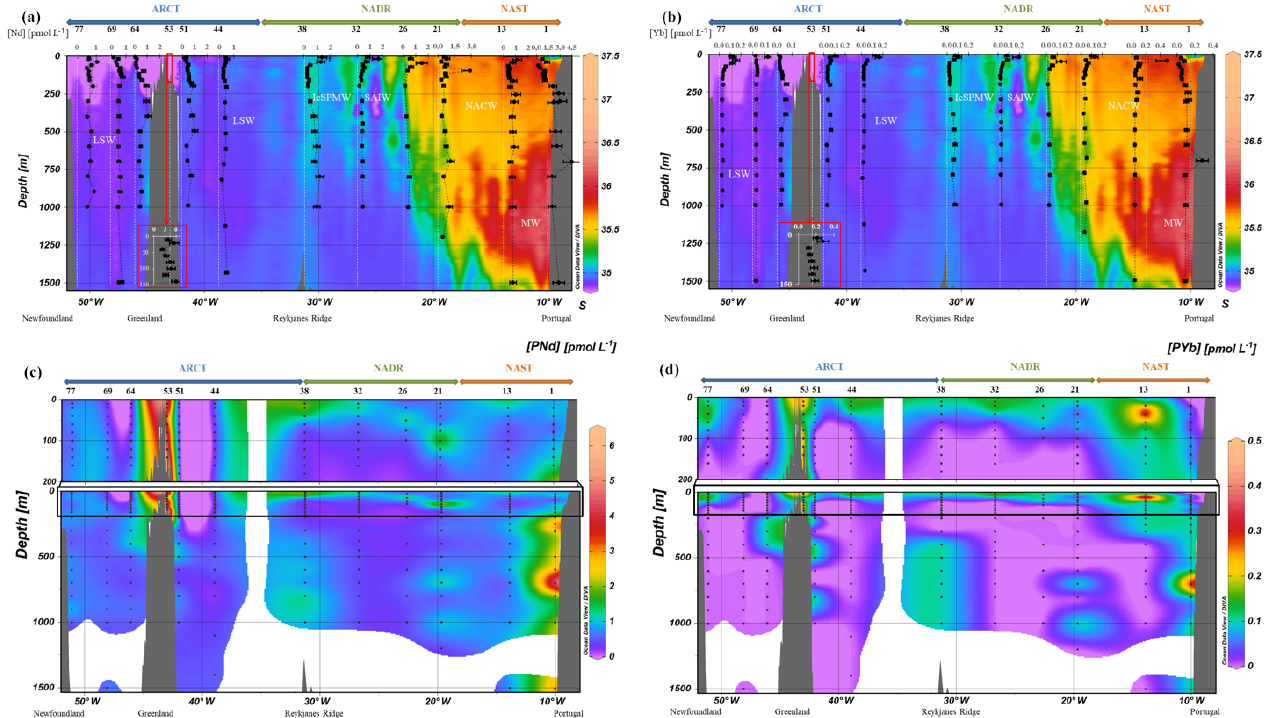
Figure 3. (a) Vertical profiles of particulate [Nd] and (b) [Yb] concentrations superimposed on salinity ( S ) measured by CTD at every GEOVIDE station (Lherminier and Sarthou, 2017); in white, the prevailing water masses characterized by a multi-parametric (OMP) analysis as in Fig. 2. At station no. 53, profiles are shifted to the bottom at a lower scale because of the shallow depth of the station. (c) Particulate [Nd] and (d) [Yb] concentrations interpolated with the DIVA gridding function of Ocean Data View along the section defined in Fig. 1, with a zoom on the first 200m in (c, d)